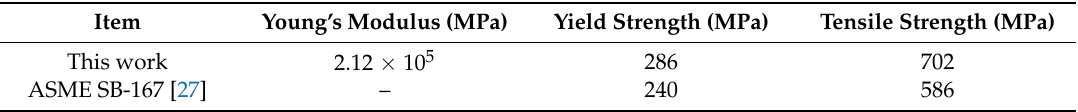
Figure 2. Stress–strain curve of Inconel 690 tube. Table 2. Tensile properties of Inconel 690.